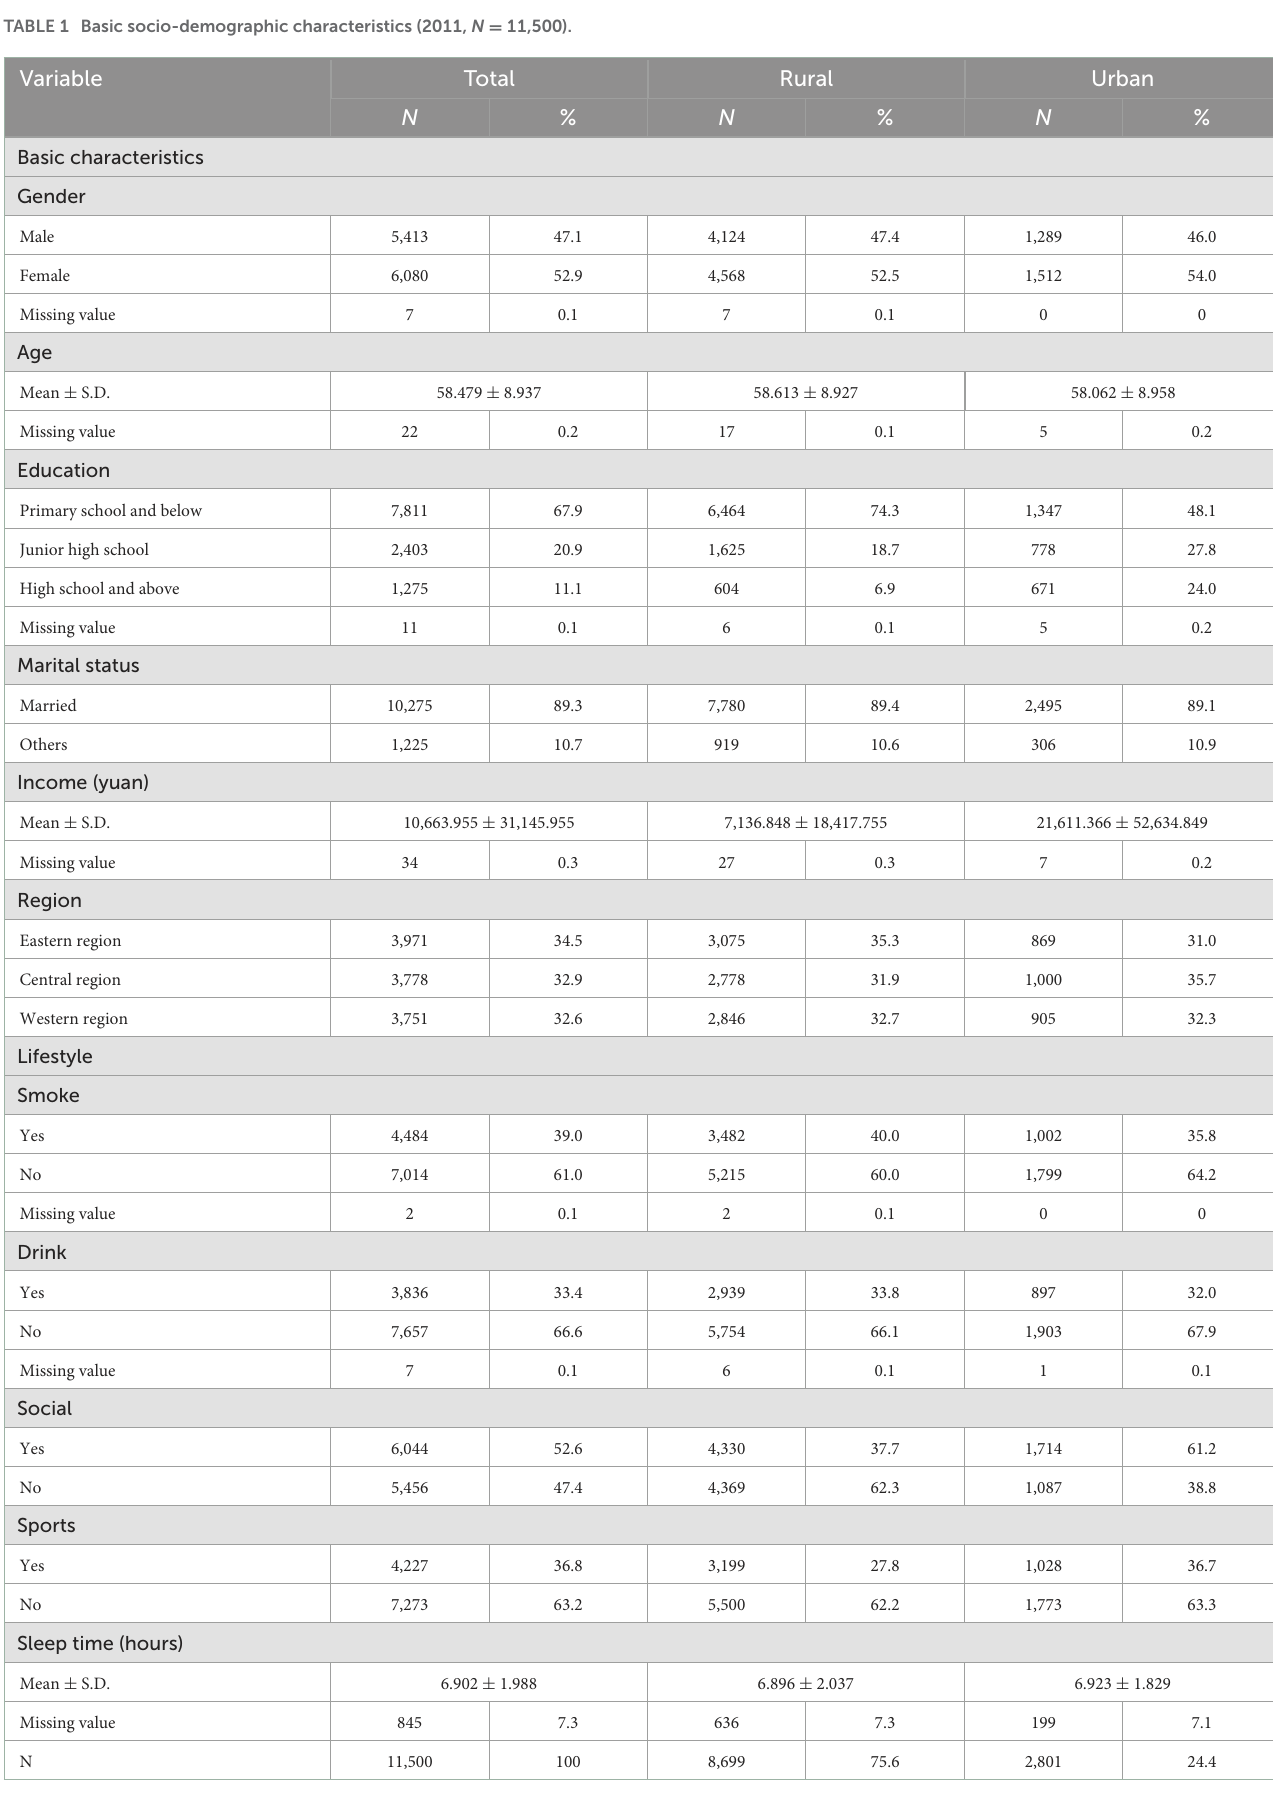
TABLE 1 Basic socio-demographic characteristics (2011, N =